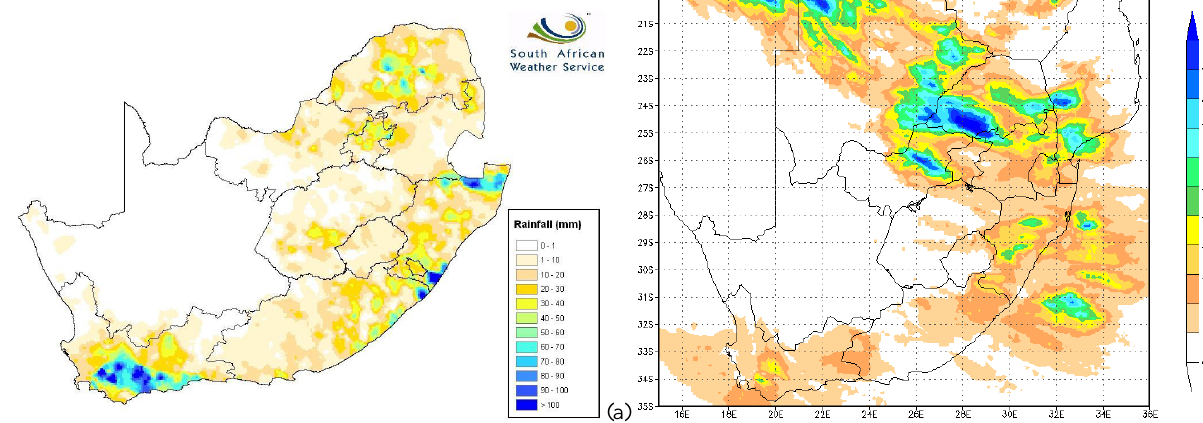
Fig. 4. Rainfall totals over 24h from rain gauges (a) and HE (b) for 12 November 2008.